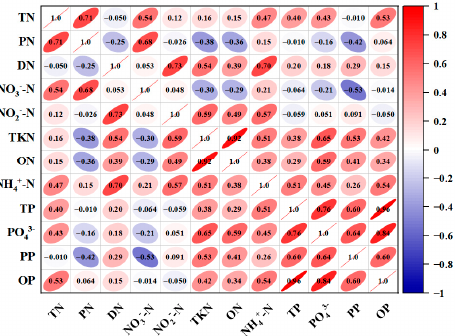
Figure 6. Correlation between different forms of nitrogen and phosphorus pollutants.